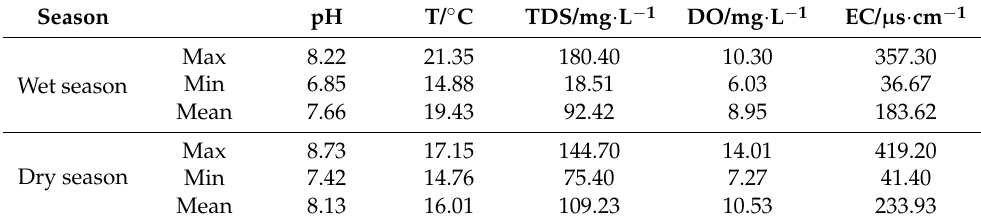
Table 2. Physicochemical parameters of surface water in the Lijiang River Basin.